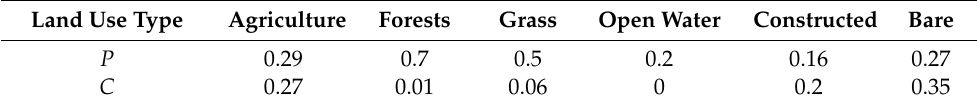
Table 2. P value and C value of different land use